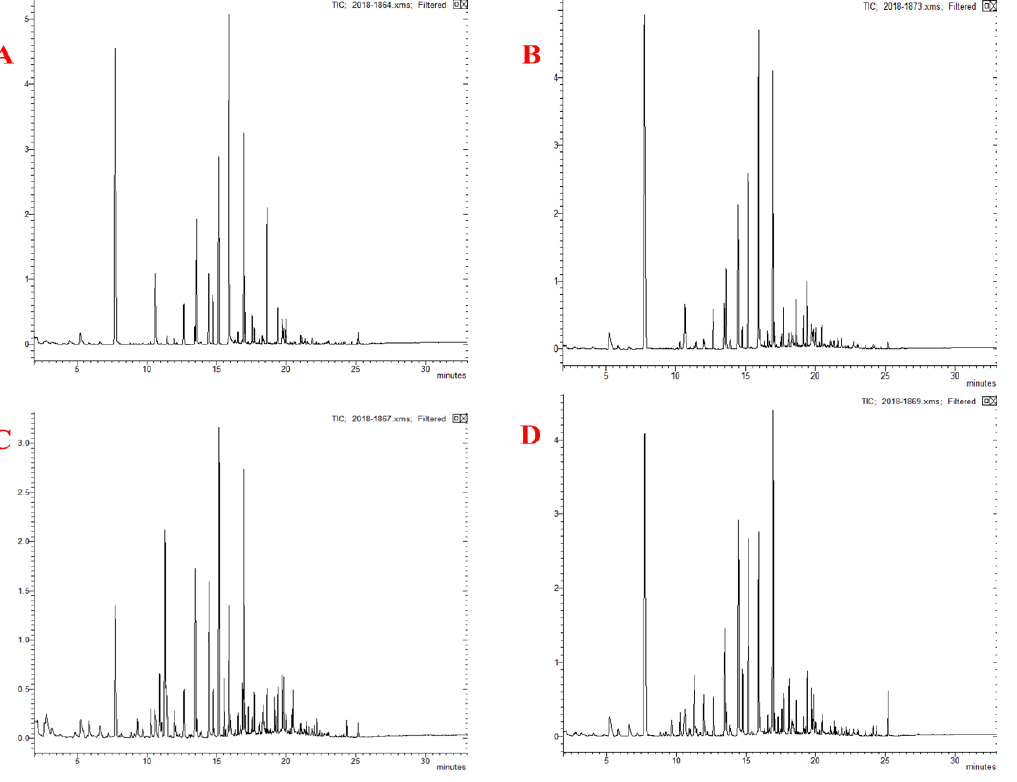
Figure 1. Total ion chromatograms (TICs) of volatile products in Daokou braised chicken during processing (Note: A – D refer to samples L1, L2, L3, L4 respectively).